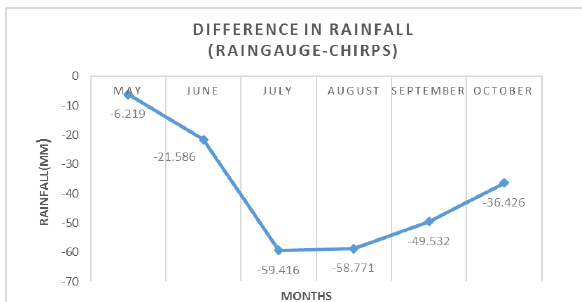
Figure 9. Difference in monthly precipitation, between CHIRPS and rain gauges, for all sample stations